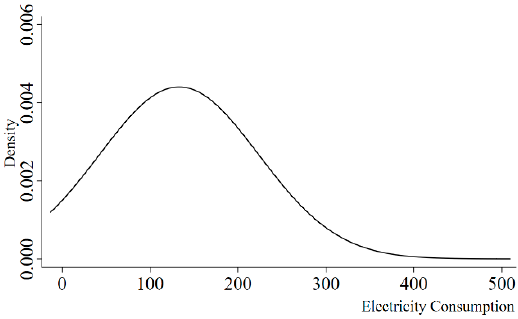
Figure 2. Kernel distribution of electricity consumption.